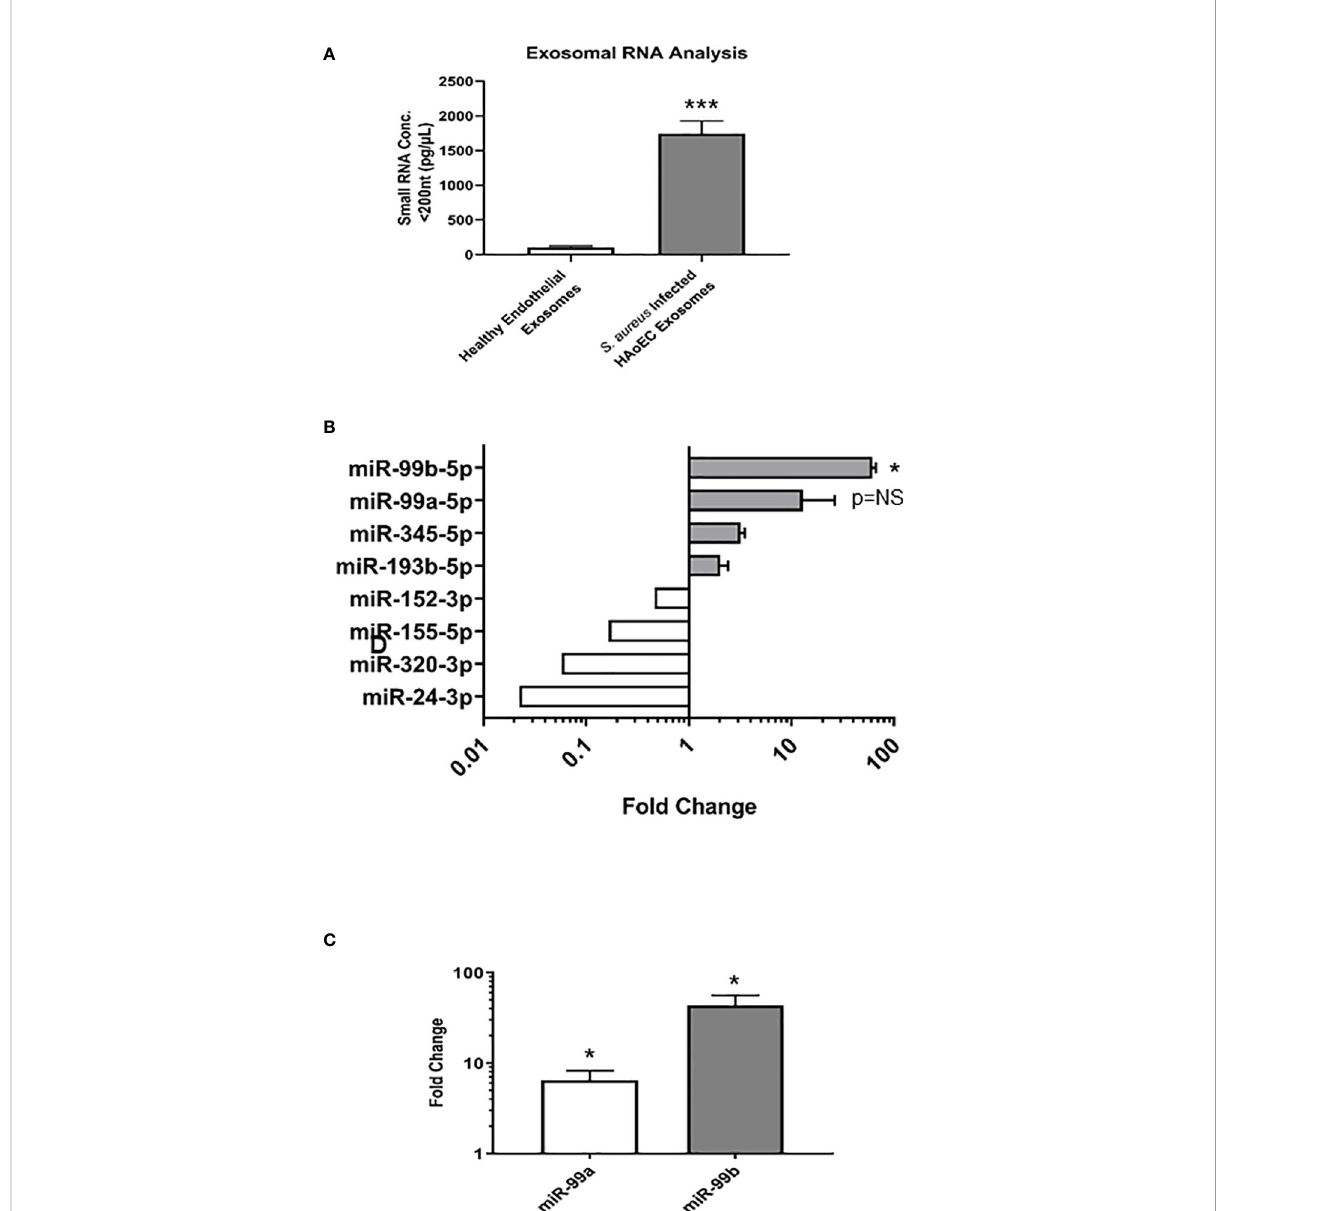
FIGURE 2 Characterisation of microRNA in healthy and infected endothelial cells (A) . Total RNA was extracted and isolated from healthy and S. aureus infected endothelial exosomes using Total Exosome RNA & Protein Isolation Kit and quanti fi ed using an AATI fragment analyser. This yielded a comprehensive miRNA expression pro fi le for healthy and S. aureus infected endothelial exosomes. Individual miRNA expression data were calculated using the comparative cycle threshold (2- DD Ct) method, which indicated a signi fi cant increase in smRNA composition as a result of S. aureus infection (B) Differential expression of four upregulated and downregulated miRNA shown by fold change, with signi fi cantly high levels observed for miR-99b relative to healthy endothelial exosomes. (C) miR-99a and miR-99b levels in infected endothelial exosomes were validated using individual real-time PCR. Signi fi cant changes in both miRNAs were observed, with a 5.11-fold increase in miR-99a expression and a 38.82-fold increase in miR-99b expression. Data is representative of 4 independent experiments, as mean ± SEM. Statistics were performed using a two-tailed paired t-test, (*p<0.05, ***p<0.0001). NS, not signi fi